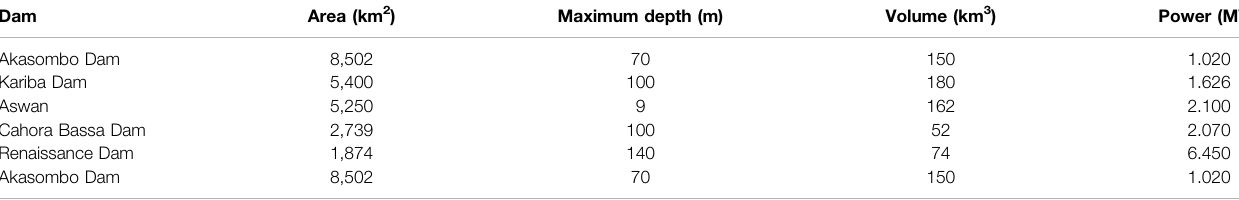
TABLE 3 | Largest dams in Africa (adapted from The New Africa Channel (2020)).